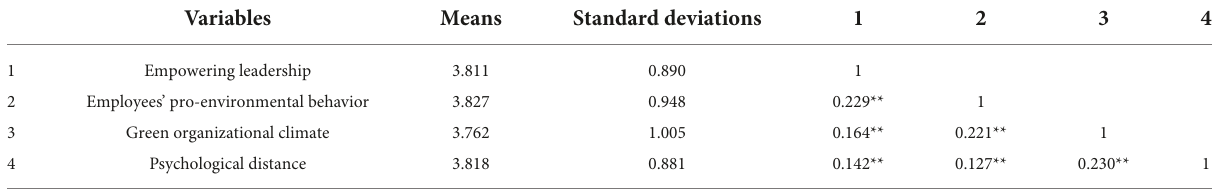
TABLE 2 The means, standard deviations, and correlations of each variable.